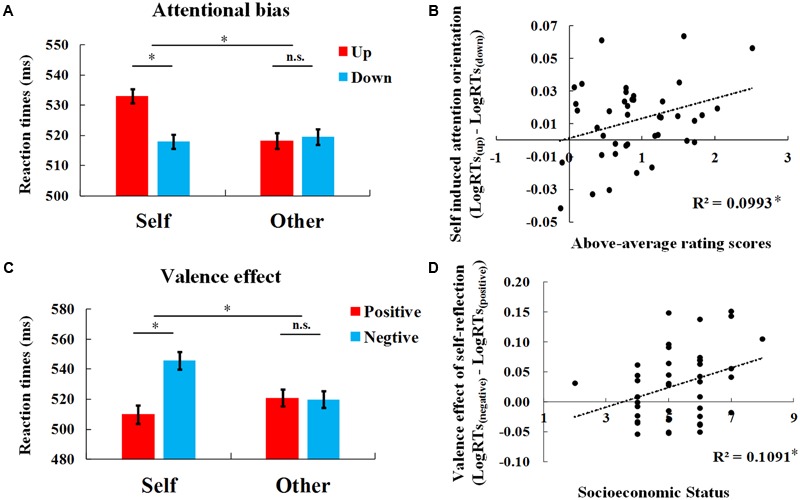
Results of Study 2. (A) RTs to targets at up and down positions after reflection. The RTs are reported in raw millisecond values to facilitate comprehension. Error bars represent within-subject standard error of the mean. (B) Correlation between downward attention orientation effects (lgRTup-lgRTdown) after self-reflection and above-average scores. (C) RTs to targets after positive and negation reflection. The RTs are reported in raw millisecond values to facilitate comprehension. Error bars represent within-subject standard error of the mean. (D) Correlation between valence effect of self-reflection (lgRTnegative-lgRTpositive) and subjective SES. ∗p < 0.05.